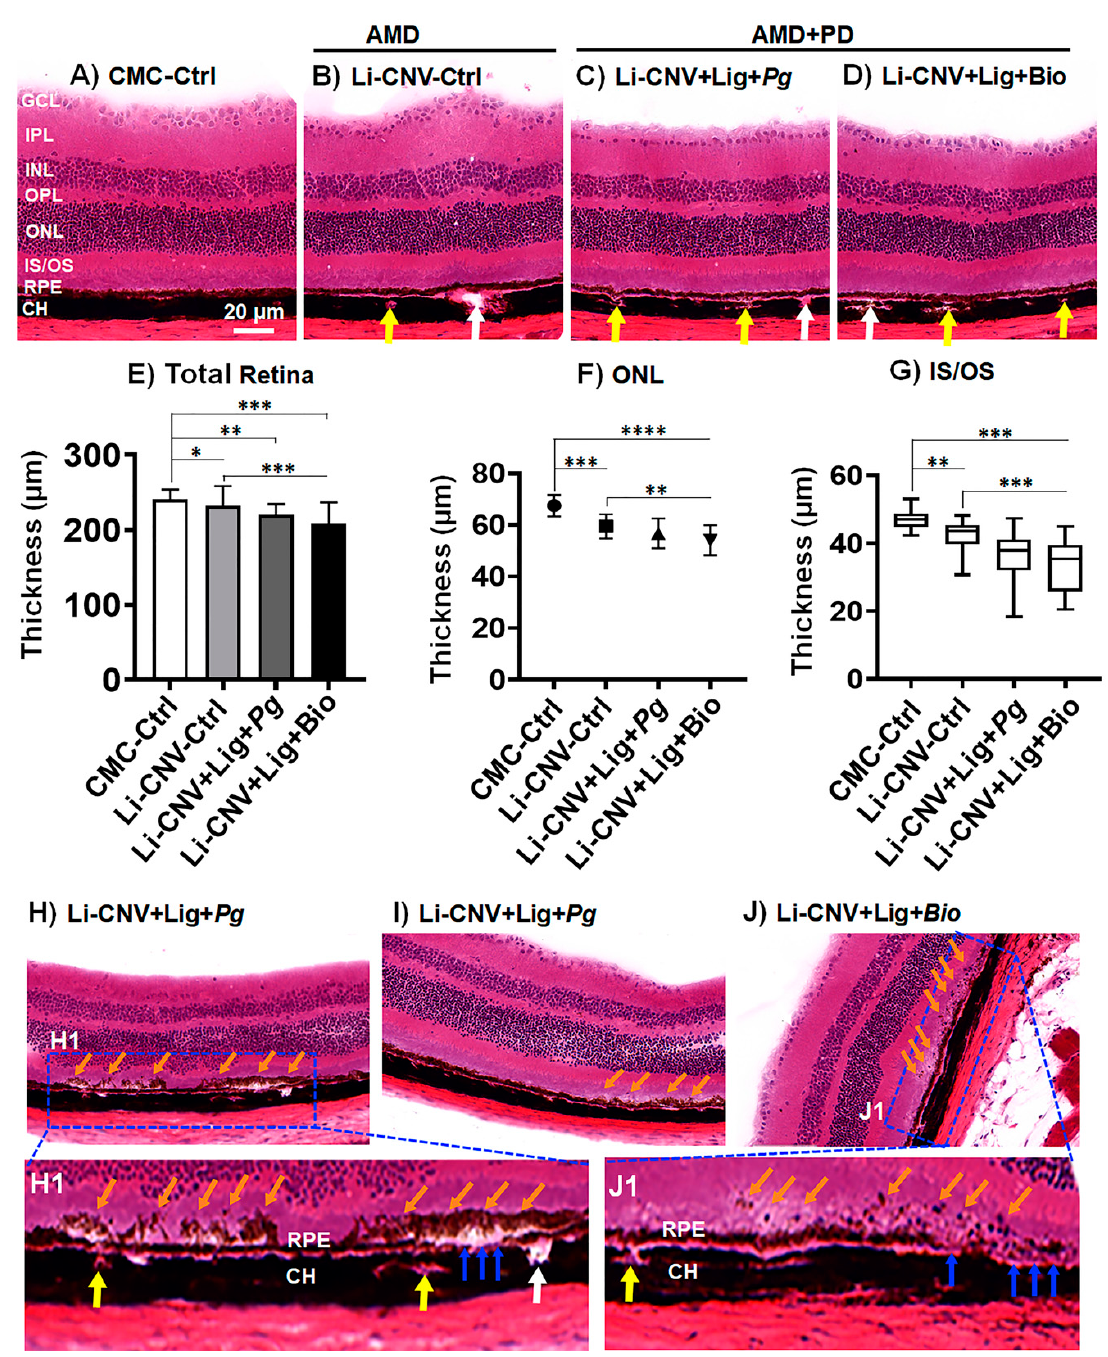
Figure 4. Decreased retinal thickness and formation of subretinal drusen-like deposits in AMD+PD mice. ( A – D ) H&E staining shows total retinal thickness of Li-CNC+Lig+ Pg and Li-CNV+Lig+Biofilm orally infected mice model after 6 weeks compared to CMC and Li-CNV controls. (Scale bar: 20µm). ( B – D ) White arrows indicate the CNV spots (empty space) while yellow arrows show the infiltration of immune cells in choriocapillaris of the AMD+PD retinae. Refer Figure S3 for another set of representative images. ( E – G ) Quantification analysis shows that the thickness of the retinal layers of AMD+PD mice was significantly reduced, including the outer nuclear layer (ONL), inner segment/outer segment (IS/OS). Total retinal thickness measured from the nerve fiber layer to the RPE layer. Mean ±SEM analyzed by One-way ANOVA followed by Dunnett’s and Tukey’s multiple comparisons test ( n = 12; **** p < 0.0001, *** p < 0.001, ** P < 0.01, * p < 0.05). ( H–J ) Representative H&E images show drusen-like deposits in the subretinal area (orange arrows) and disintegrated RPE layer in Pg and Biofilm infected mice. Boxed areas in H and J show an enlarged region as H1 and J1 clearly demonstrate the RPE damage (yellow arrows) and drusenoid deposits in the subretinal area (orange arrows), respectively.